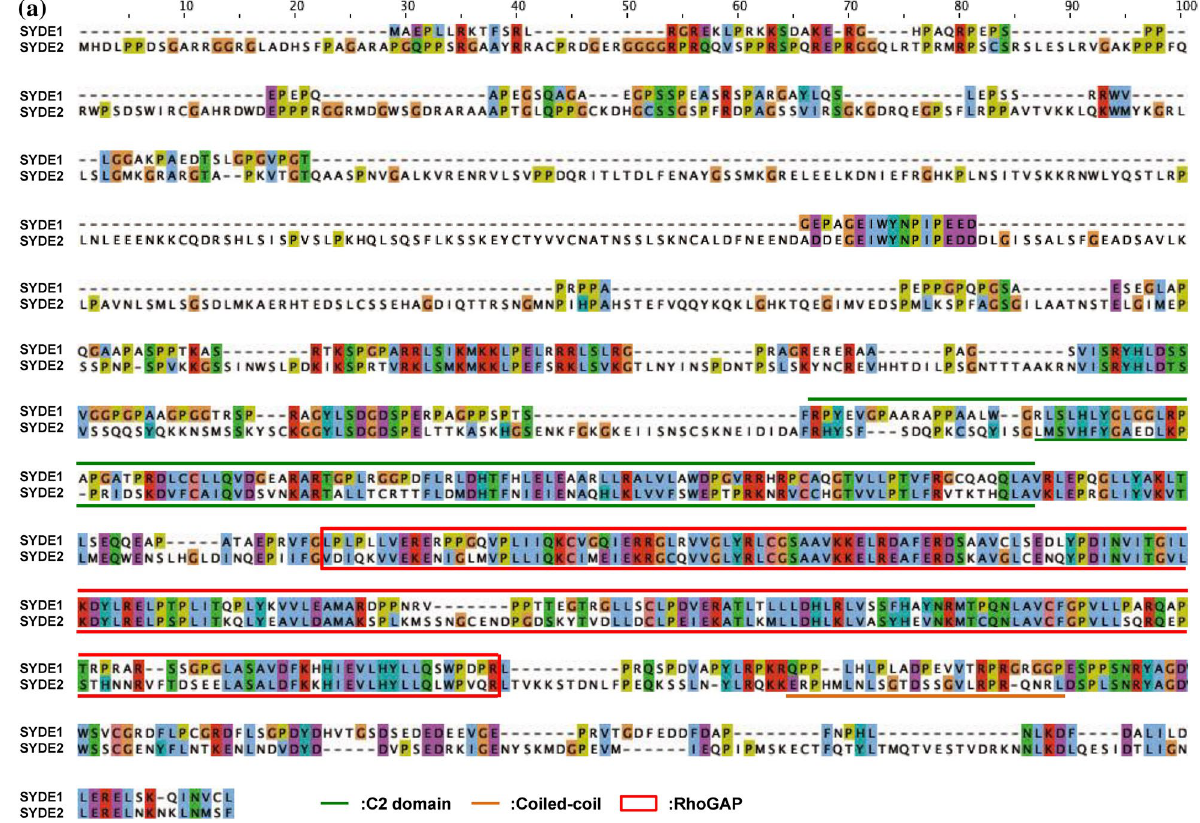
Figure 3. Multiple alignments of SYDE proteins. Color code is based on Clustalσ scheme and linear motifs are identified by ELM and D 2 P 2 database Anchor definition 22 . ( a ) Alignment of SYDE1 and SYDE2. ( b ) Syde1 N-terminus and C-terminus. ( c ) Syde2 N-terminus and C-terminus. The signatures indicate: LIG_SH2_CRK/ NCK: Crk and Nck SH2 domain binding motif; LIG_14-3-3; 14-3-3 binding motif; DOC_Cyclin_RxL: Cyclin/ CDK binding motif; LIG_WW3: PPR-specific WW domain; DOC_MAPK: a docking motif for interaction with Erk1/2 and p38 subfamilies of MAP kinases; DOC_PP2B_LxvP1: calcineurin docking motif; DOC_PP4: a docking motif recognized by PP4 holoenzyme; MOD_CK1: CK1 phosphorylation site; MOD_CK2: CK2 phosphorylation site; MOD_GSK3: GSK3 phosphorylation recognition site; LIG_SH2_GRB2: Grb2-like SH2 binding motif; LIG_SH3_3: SH3 binding motif; DEG_SCF_FBW7: Phsopho-dependent degron recognized by FBW7 Fbox proteins; LIG_LIR_Gen1: LIR motif for ATG8-mediated